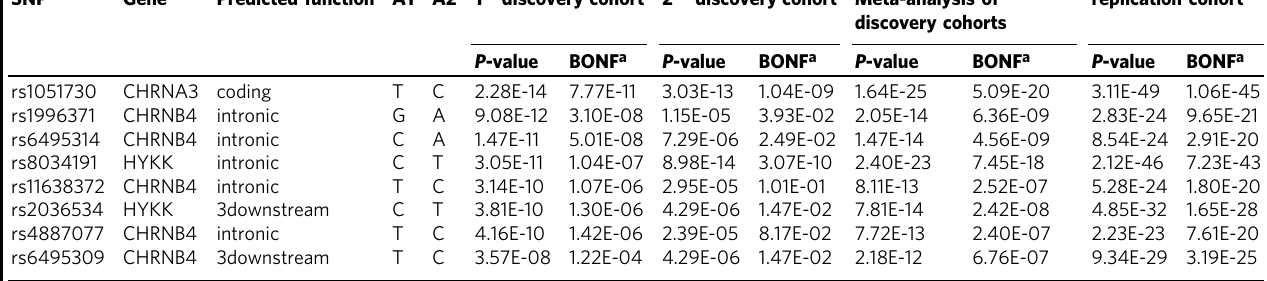
Table 2 Index SNPs in the chromosome 15q25.1 locus which were associated with lung cancer with P < 5.00E-8 in the 1st discovery cohort and in meta-analysis of the discovery cohorts SNP